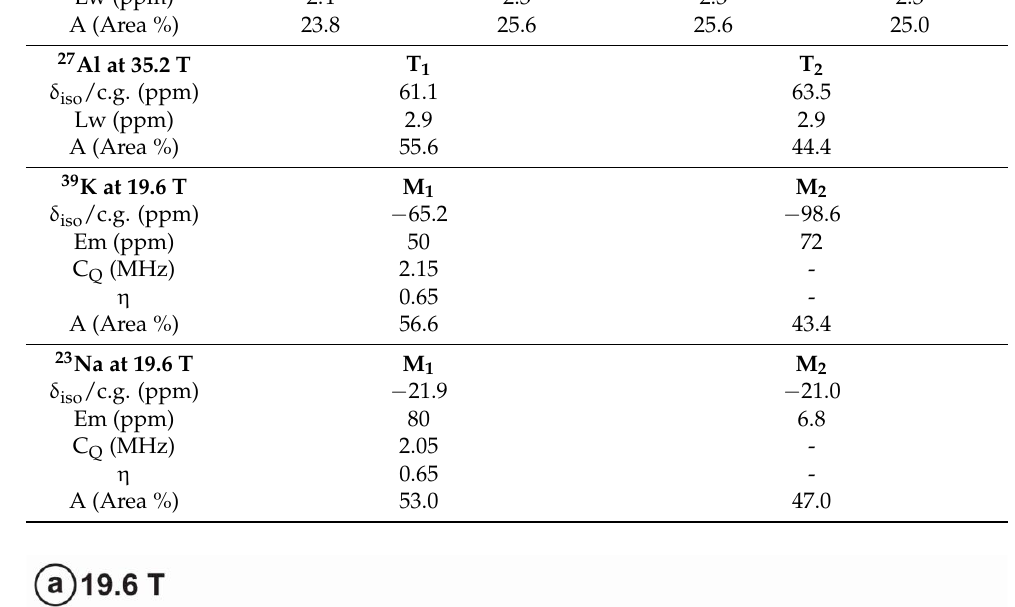
Table 5. NMR parameters from spectral simulations of the NMR spectra of specimen AGM with a ”valencianite” structure (Figure 10).